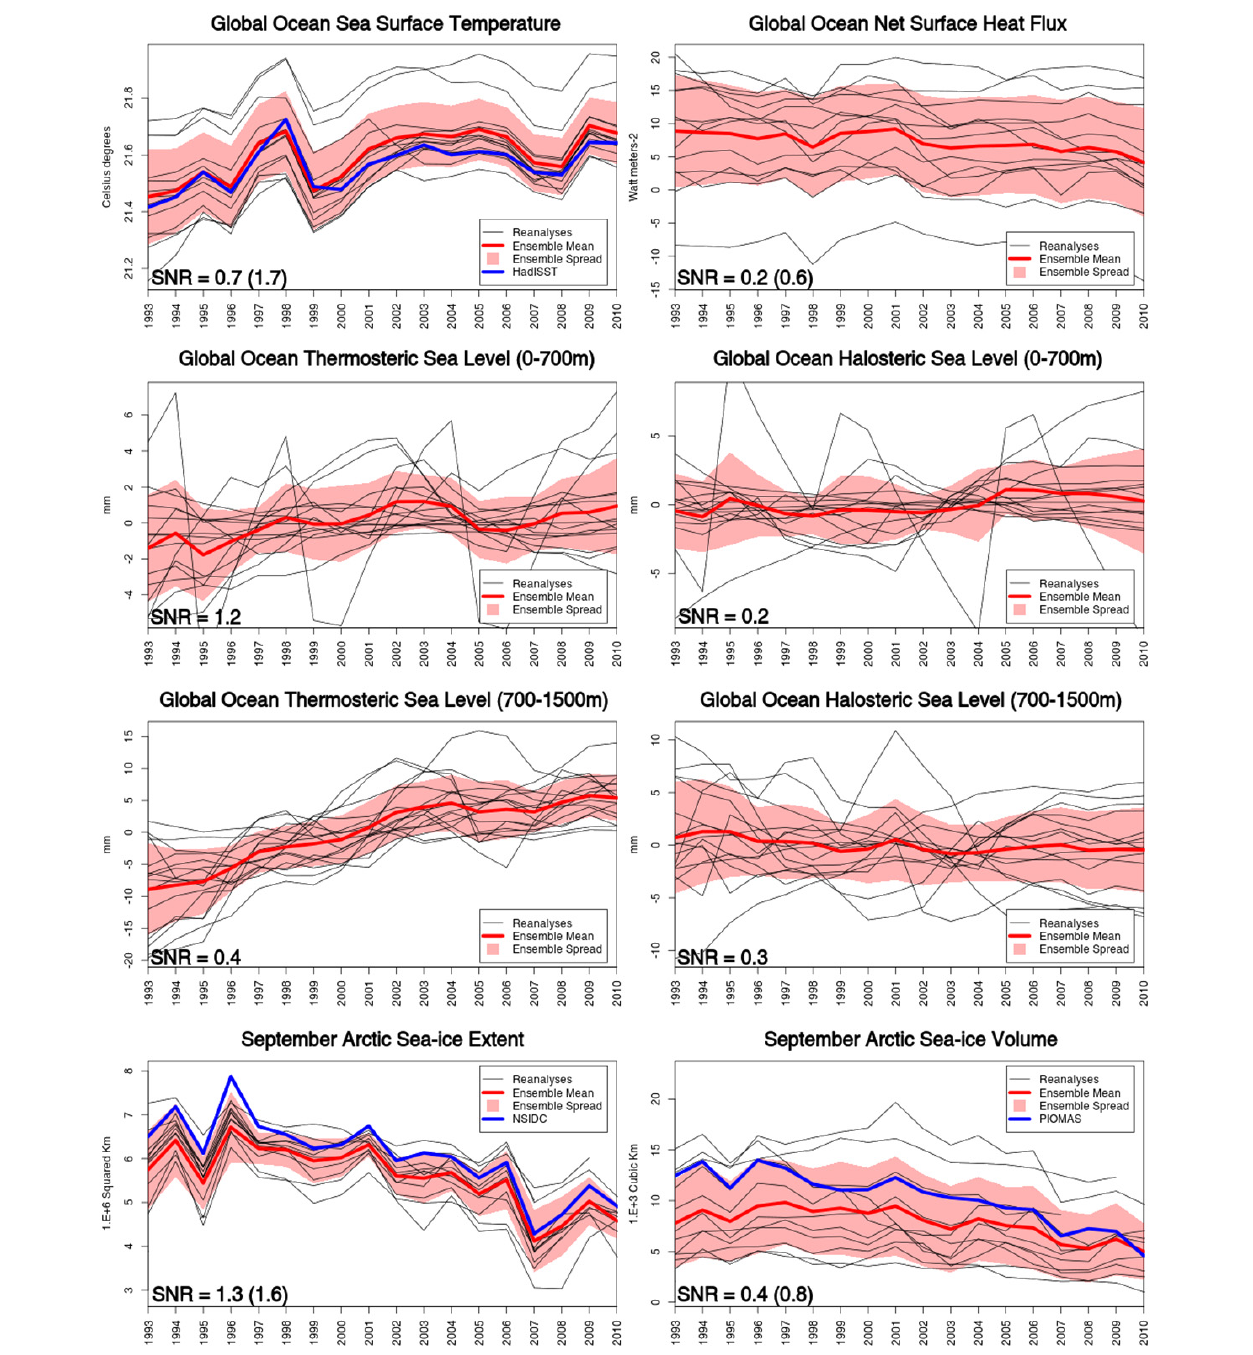
FIGURE 2 | Timeseries of global ocean sea surface temperature, net surface heat flux, thermo, and halo steric sea level (0–700 and 700–1500 m), September Arctic sea-ice extent and volume, from the ORA-IP inter-comparison project. Each plot shows the ensemble mean and standard deviation and the individual ocean reanalyses. Reference datasets are shown in blue for selected parameters. Each plot reports also the Signal-to-noise ratio (SNR), defined here for simplicity as the ratio between the temporal standard deviation of the ensemble mean divided by the temporal mean of the ensemble standard deviation. Numbers in parentheses refer to the SNR ratio computed from anomalies rather than full field data, except for thermo and halo steric sea level data that are already anomalies by construction. Adapted from Chevallier et al. (2017), Storto et al. (2017), and Valdivieso et al. (2017). Image reproduced with permission of the rights holder.